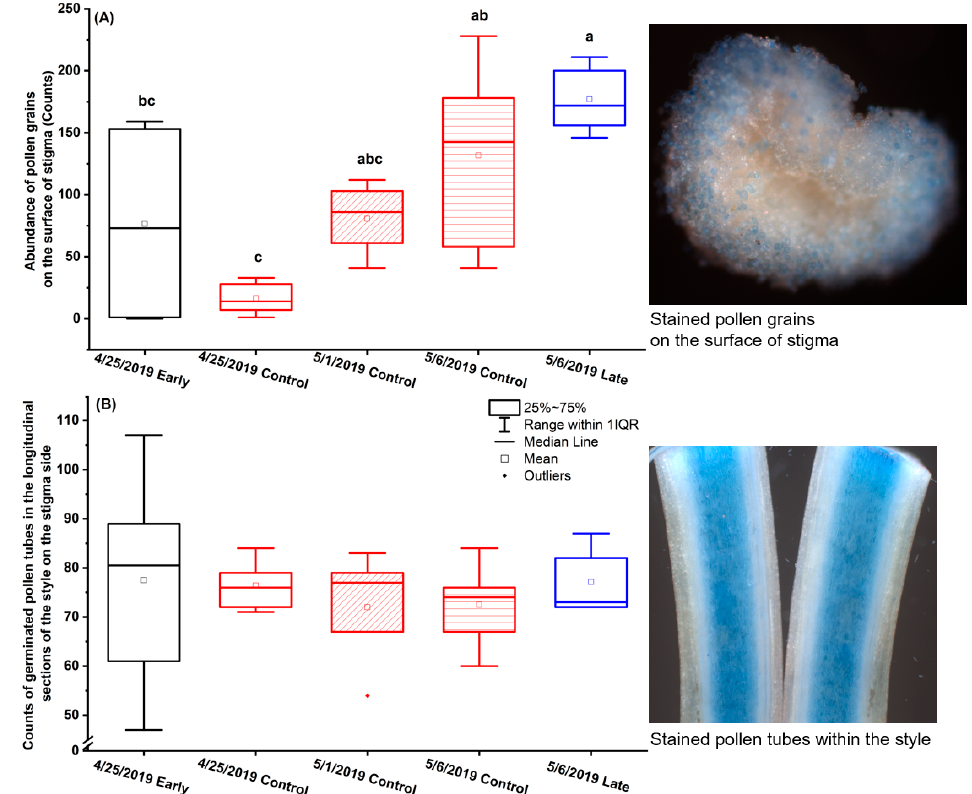
Figure 2. Impacts of fatty acid methyl esters (FAME) on ( A ) pollen abundance on the surface of stigma and ( B ) number of germinated pollen tubes in the longitudinal sections of the style on the stigma side of ‘Lapins’ sweet cherry in the spring of 2019 at SuRDC1. The early spray (Early) was applied on 7 March and flowers were sampled on 25 April. The late spray (Late) was applied on 1 April and flowers were sampled on 6 May. Flowers of Control treatment were sampled on 25 April, 1 May and 6 May. Pollen grains and pollen tubes were stained with Aniline Blue (n = 6 flowers). Boxplots show median (horizontal line) and interquartile ranges. In ( A ), the letters stand for significant difference at p < 0.05 [ANOVA, Tukey’s test for pairwise comparison, F(4,22) = 6.97, p < 0.001].